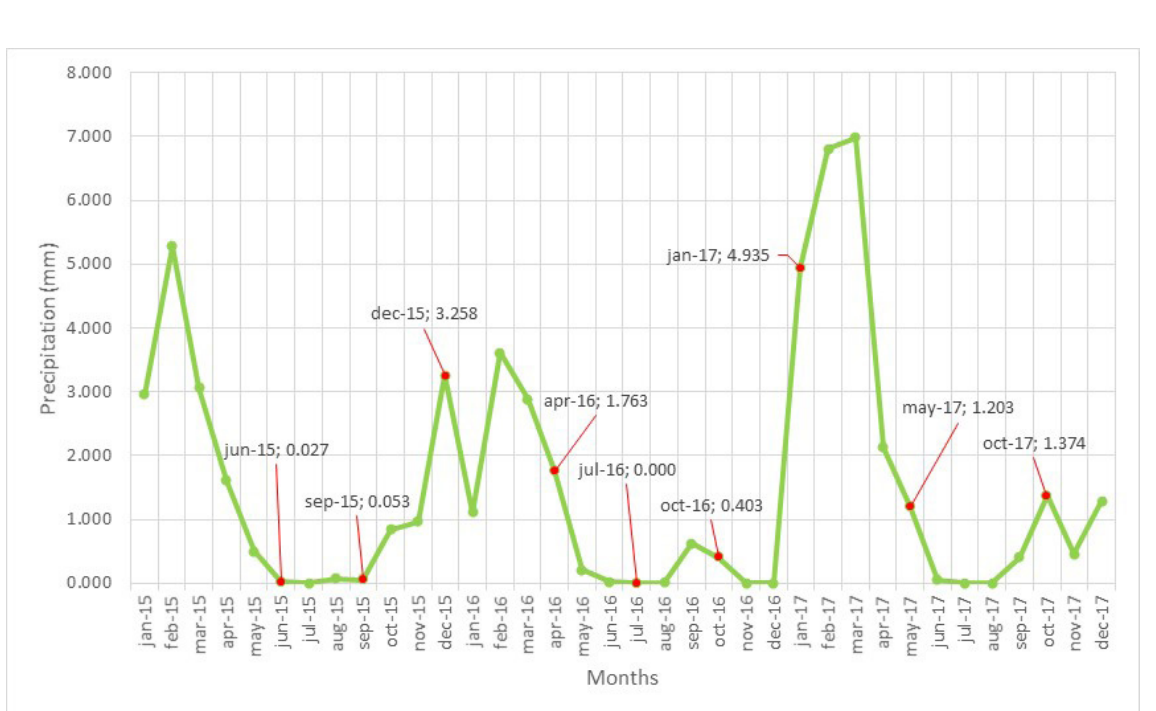
Figure 3. Evolution of average monthly precipitation (mm) from January 2015 to December 2017. Source: Cajatambo CWS, SENAMHI.